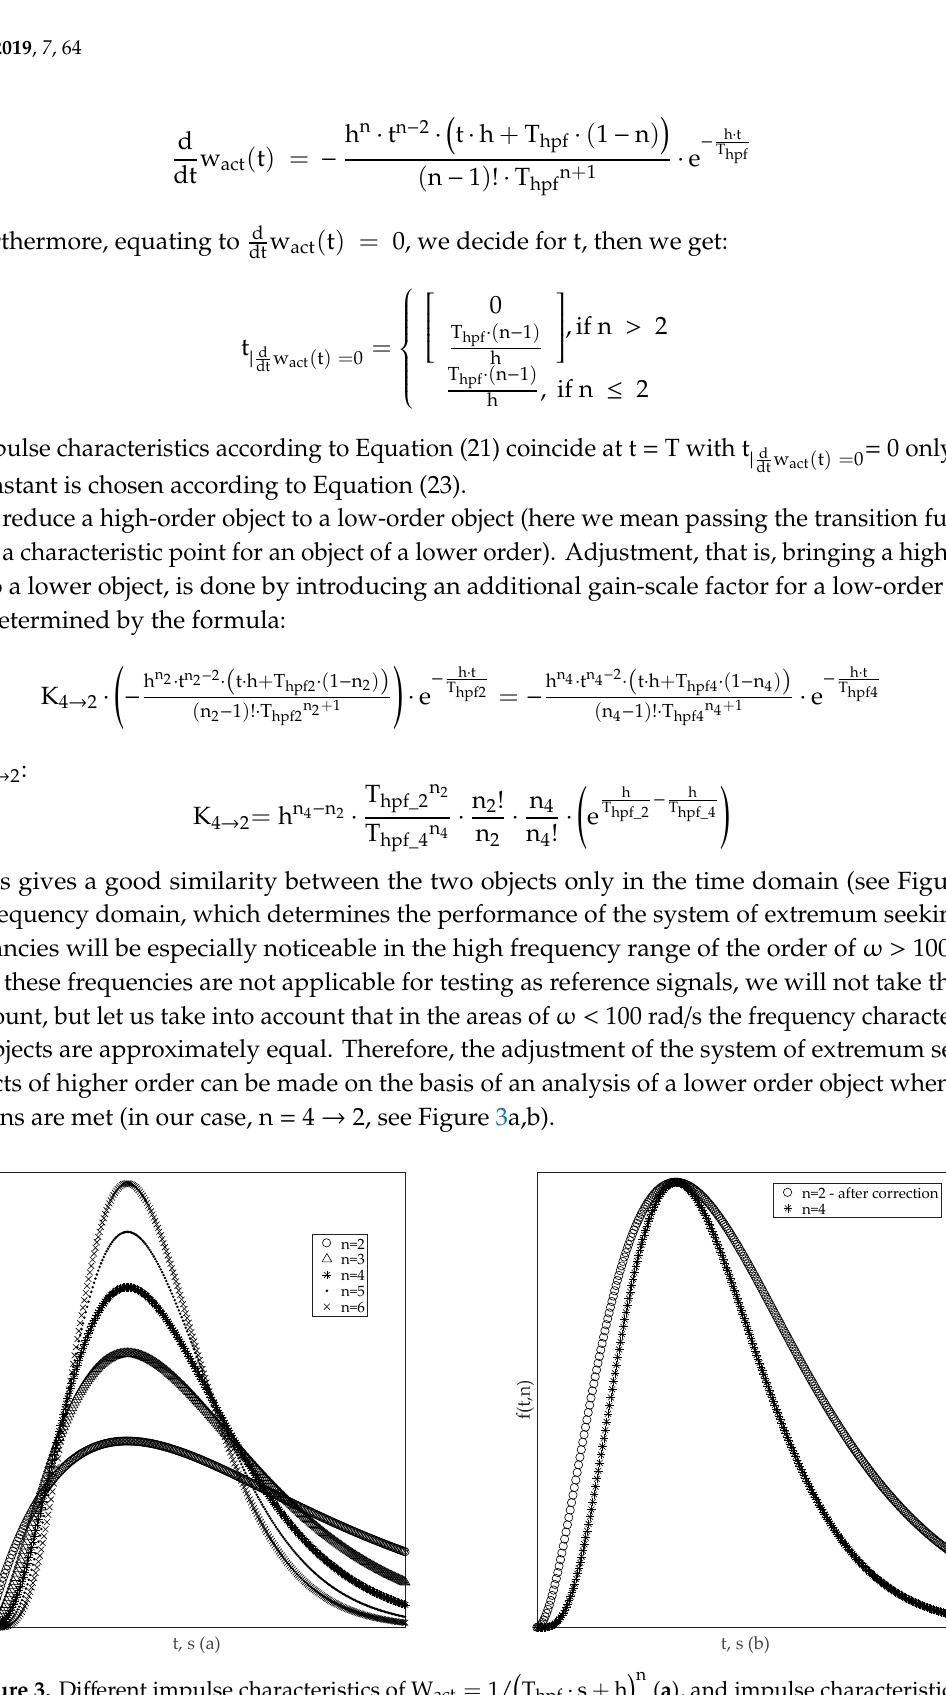
Figure 3. Different impulse characteristics of W act = 1/(cid:3435) T hpf ⋅ s+h (cid:3439) n ( a ), and impulse characteristics of Figure 3. Di ff erent impulse characteristics of W act = 1/ n=2 and n=4 objects after corrections in time domain ( b ). of n = 2 and n = 4 objects after corrections in time domain ( b